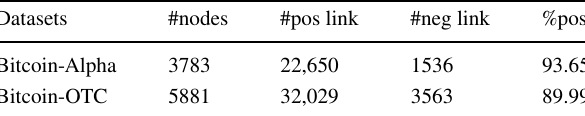
Table 2 Statistics of datasets